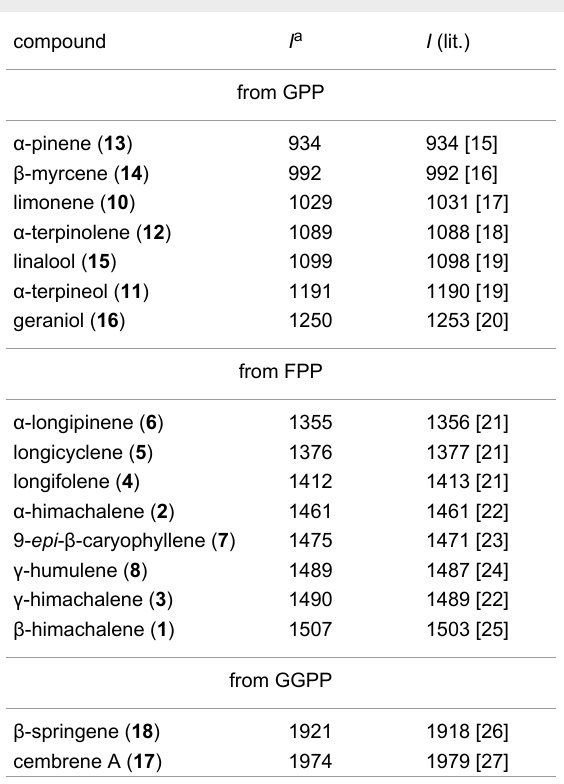
Table 1: HcS product identification by retention